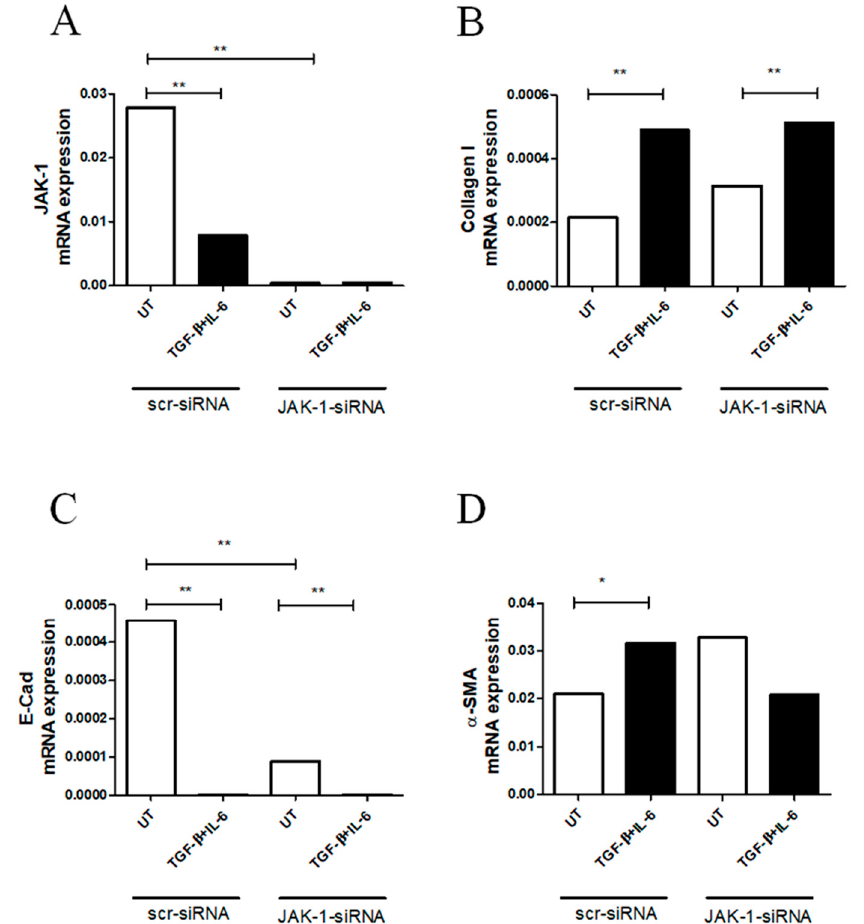
Figure 3. The silencing of JAK-1 gene did not fully affect the effects induced by TGF- β and IL-6. ( A ) JAK-1-siRNA efficiently knocked down JAK-1 molecule in RA-FLSs, and, after silencing, TGF- β + IL6 were unable to modulate the JAK-1 expression; qRT-PCR of JAK- 1 (JAK-1 mRNA expression in scr-siRNA untreated (UT)-RA-FLSs 0.027 (0.023–0.042) vs. JAK-1 mRNA expression in JAK-1-siRNA UT-RA-FLSs 0.00037 (0.00035–0.00050, p = 0.002), (JAK-1 mRNA expression in scr-siRNA UT-RA-FLSs 0.027 (0.023–0.042) vs. JAK-1 mRNA expression in scr-siRNA RA-FLSs treated with TGF- β + IL-6 0.0078 (0.0029–0.0093), p = 0.002). ( B ) In the RA-FLSs silenced with JAK-1-siRNA, TGF- β + IL-6 stimulation induced a more significant increase in collagen I than UT cells; collagen I (collagen I mRNA expression in JAK-1-siRNA UT-RA-FLSs 0.00031 (0.00030–0.00040) vs. collagen I mRNA expression in JAK-1-siRNA RA-FLSs treated with TGF- β + IL-6 0.00051 (0.00043–0.0025), p = 0.002; Collagen I mRNA expression in scr-siRNA UT-RA-FLSs 0.00021 (0.00013–0.00026) vs. collagen I mRNA expression in scr-siRNA RA-FLSs treated with TGF- β + IL-6 0.00048 (0.00042–0.00062), p = 0.002). ( C ) In the cells silenced with JAK-1-siRNA, the treatment with TGF- β + IL-6 promoted a sig- nificant decrease in E-Cad mRNA expression when compared to UT cells; E-Cad, (ECad mRNA expression in JAK-1-siRNA UT-RA-FLSs 8.98 × 10 − 5 (7.50 × 10 − 5 –0.0001512) vs. E-Cad mRNA expres- sion in JAK-1-siRNA RA-FLSs treated with TGF- β + IL-6 9.45 × 10 − 7 (2.02 × 10 − 8 –6.52 × 10 − 6 ), p = 0.004; E-Cad mRNA expression in scr-siRNA UT-RA-FLSs 0.00045 (0.00040–0.00094) vs. E-Cad mRNA ex- pression in scr-siRNA RA-FLSs treated with TGF- β + IL-6 7.03 × 10 − 7 (3.07 × 10 − 9 –2.12 × 10 − 6 ), p = 0.004). ( D ) In scr-siRNA, TGF- β and IL-6 induced a significant increase in α -SMA mRNA levels. α - SMA; ( α -SMA mRNA expression in scr-siRNA UT-RA-FLSs 0.020 (0.020–0.03) vs. α -SMA mRNA expression in scr-siRNA RA-FLSs treated with TGF- β + IL-6 0.036 (0.027–0.041), p = 0.04). The histo- gram showed median of triplicate experiments (* = p < 0.05 > 0.001; ** = p < 0.001).